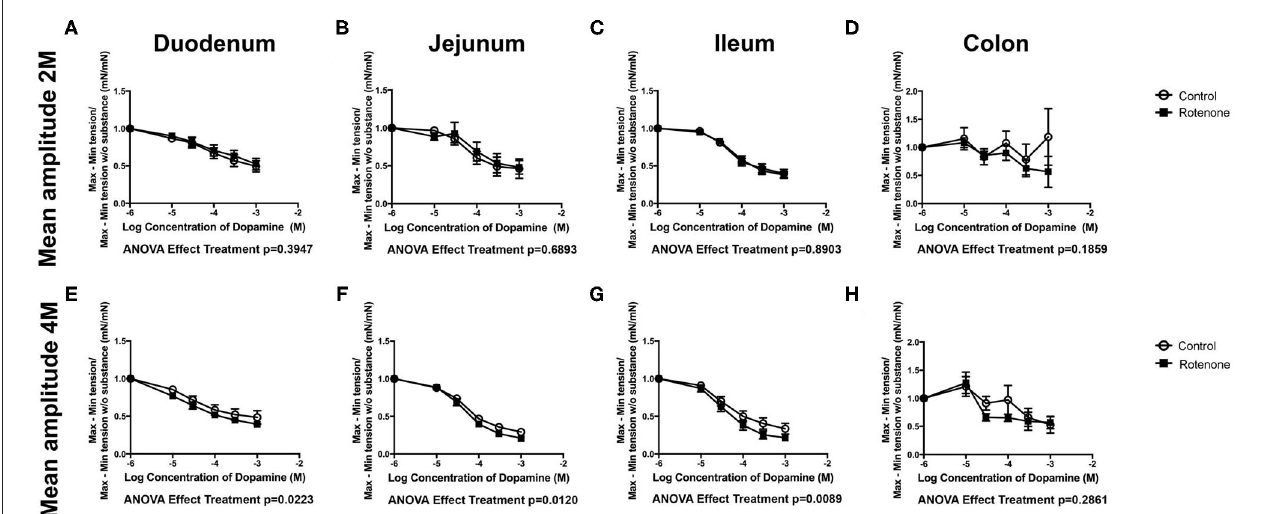
FIGURE 4 | Two- and 4-Month rotenone exposure in mice increases the sensibility to dopamine in duodenum and jejunum. Effect of dopamine treatment on the amplitude (Mean amplitude) of the duodenum (A,E) , jejunum (B,F) , ileum (C,G) , and colon (D,H) from control or 2 or 4 months rotenone-exposed mice. Data was analyzed using a 2-way ANOVA and a Bonferroni post-hoc test. Values of the effect of exposure are shown under the corresponding graph. *, **, *** correspond to P < 0.05, P < 0.01, and P < 0.001, respectively for each concentration obtained with the Bonferroni post-hoc test. Error bars represent SEM in all graphics.